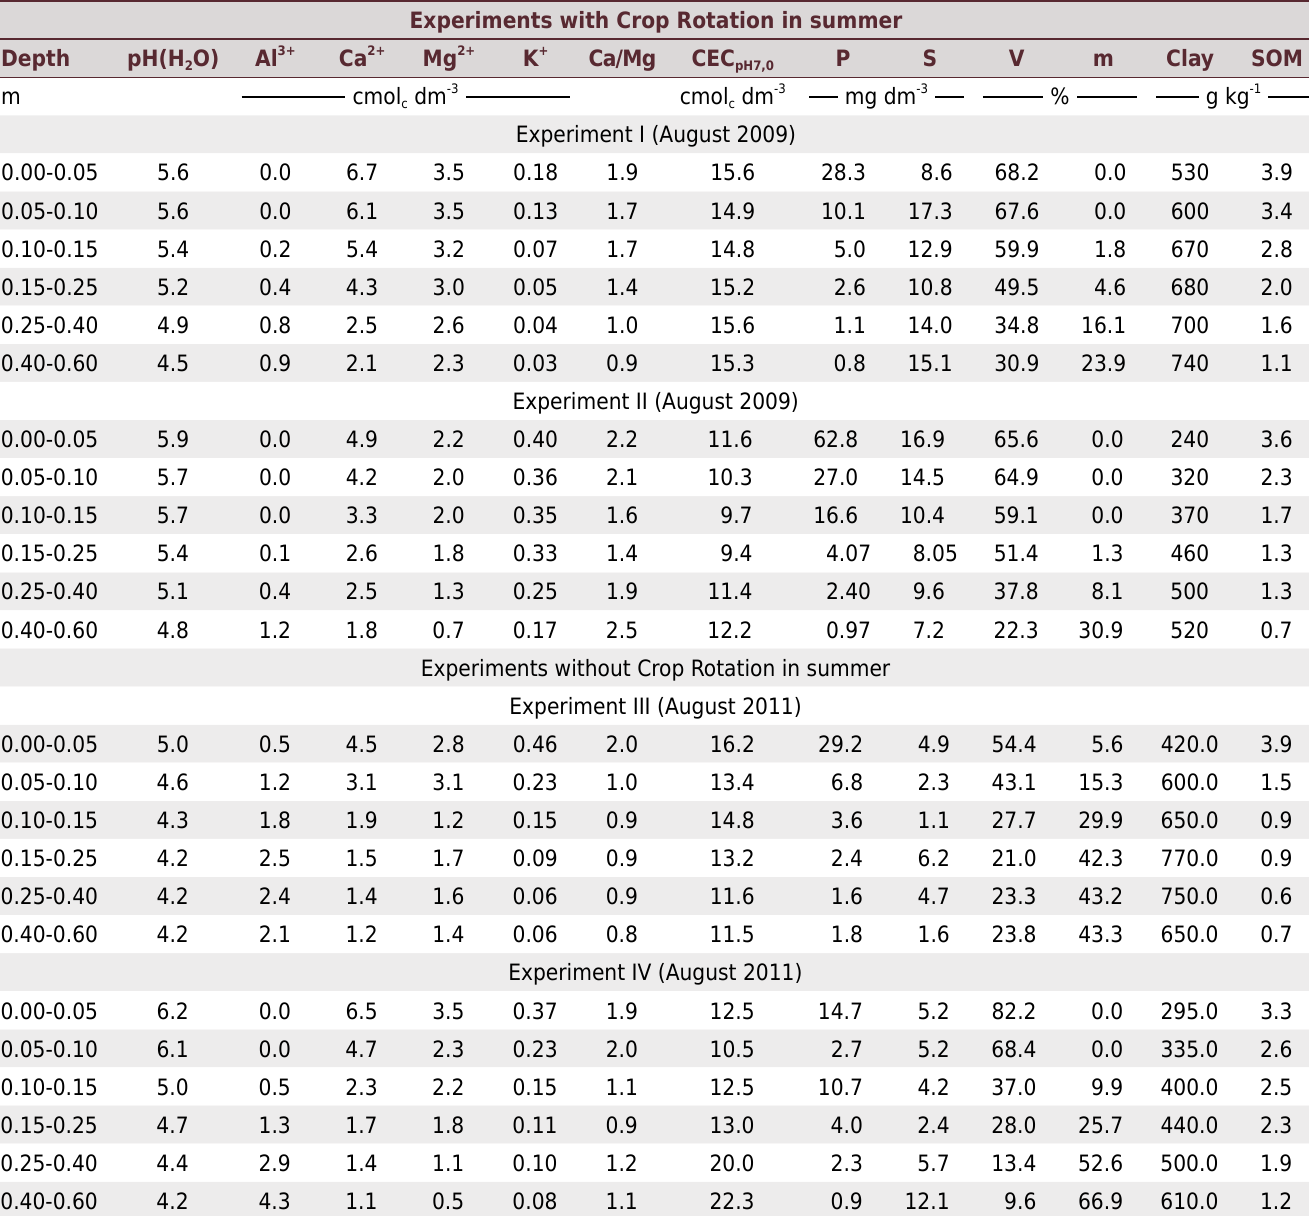
Table 3. Soil chemical properties before implementation of the treatments in the four experimental areas in dystrophic Oxisols managed under a no-tillage system in RS, Brazil Experiments with Crop Rotation in